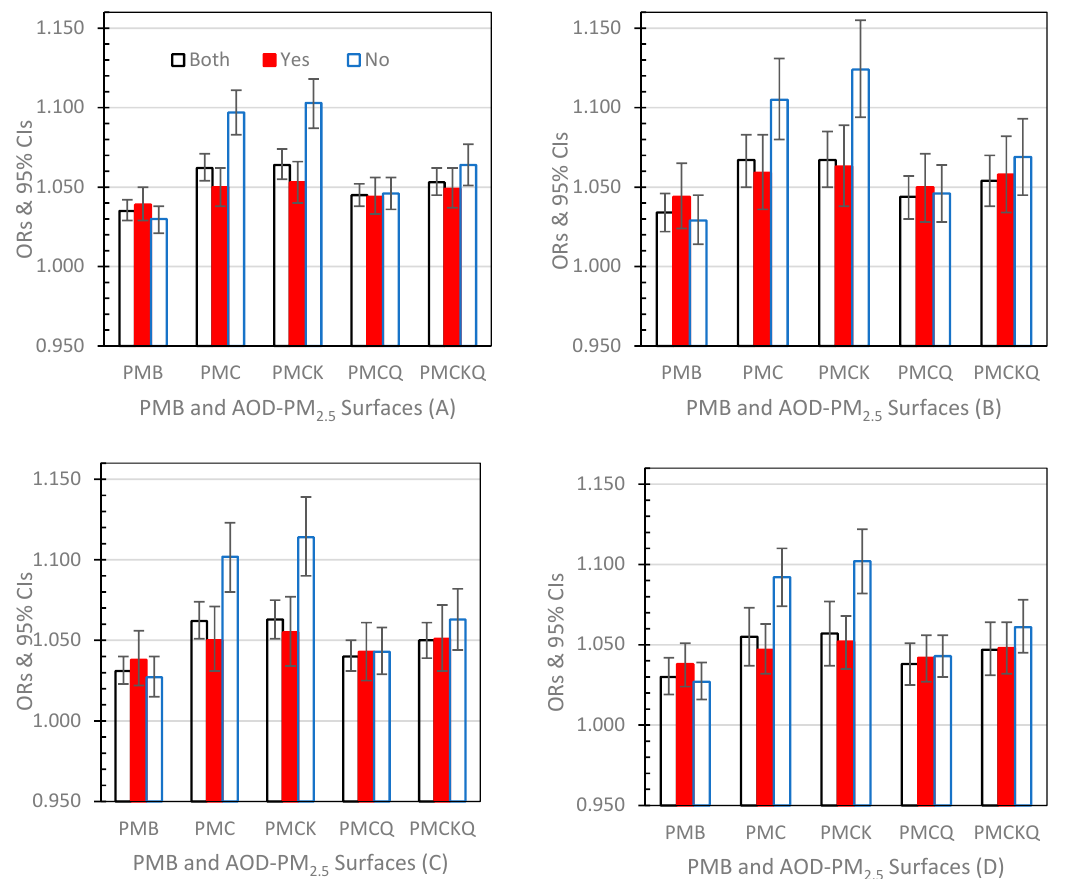
Figure 4. Odds Ratios (ORs) and 95% Confidence Intervals (CIs) for the four experimental AOD-PM 2.5 concentration surfaces and PMB under both grid conditions (Both), grids with monitors (Yes) and grids without monitors (No) at lag days 01: ( A ) ED asthma (top left panel), ( B ) IP asthma (top right panel), ( C ) IP MI (bottom left panel), and ( D ) IP HF (bottom right panel).